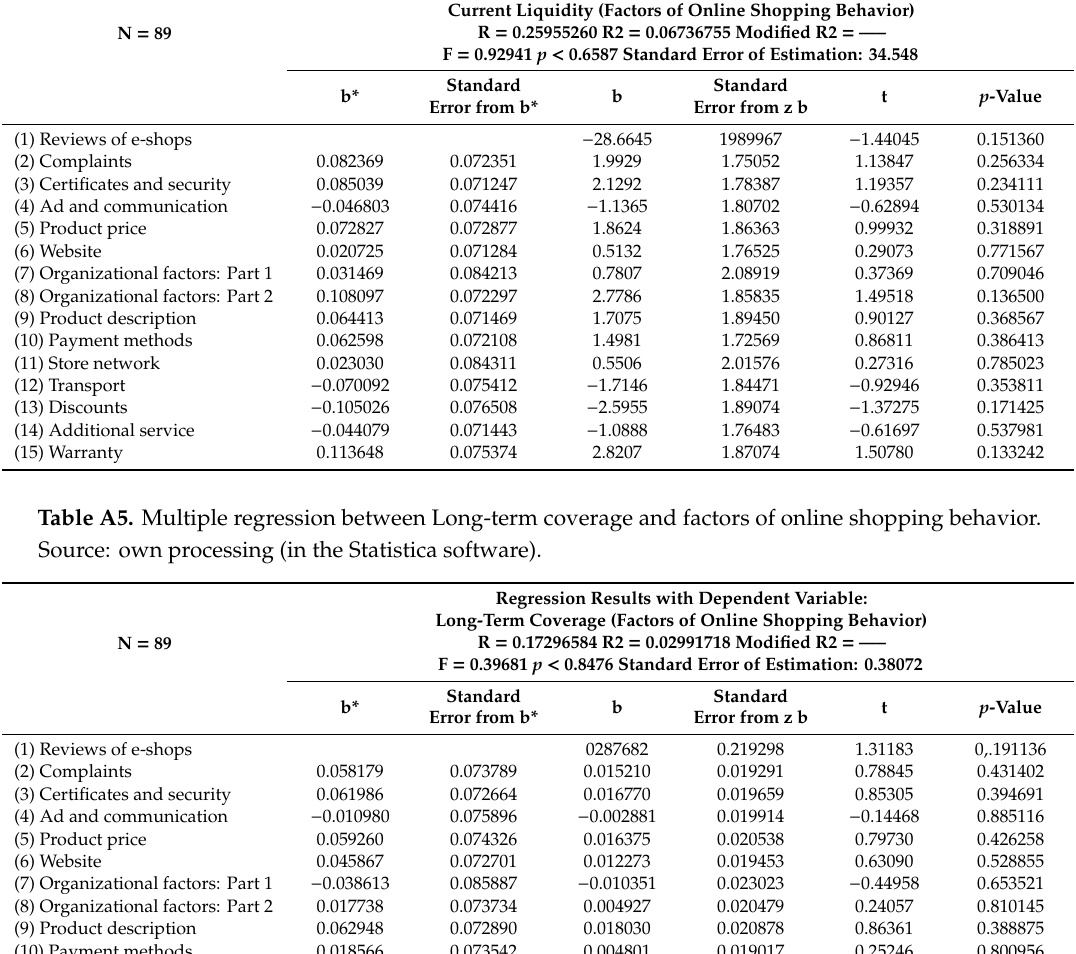
Table A4. Multiple regression between Current liquidity and factors of online shopping behavior. Source: own processing (in the Statistica software). Regression Results with Dependent Variable: Current Liquidity (Factors of Online Shopping Behavior) N = 89